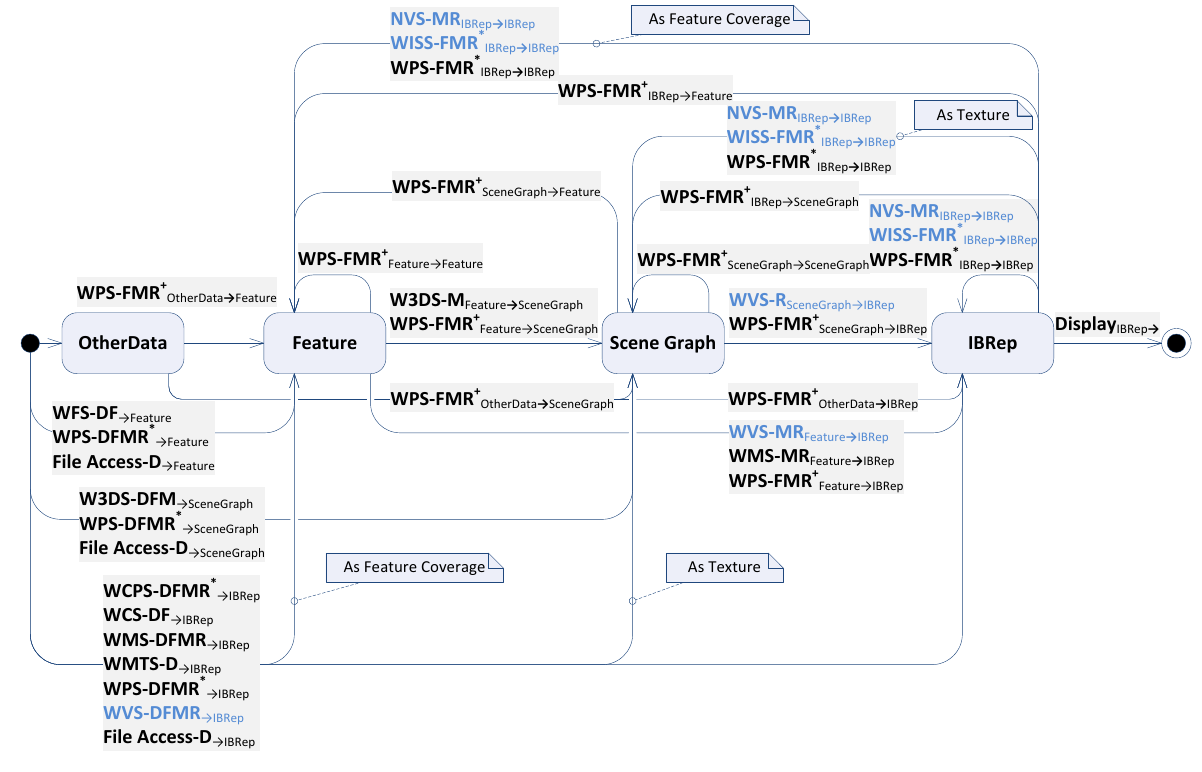
Figure 8. The space of possible linear service chains that each implements a generalized visualization pipeline composed from different service instance types depicted as a UML state diagram. States represent 3D model representation types, transitions represent data transformations using one of the listed service instance types and transition paths from the initial to the final state represent service chains. Blue font color indicates service instance types introduced in this